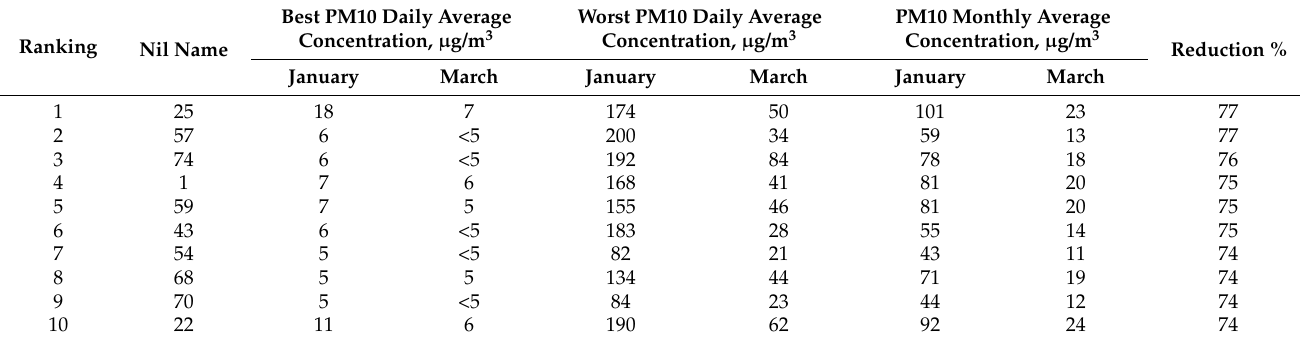
Table 3. Top 10 NILs with the highest PM10 reduction rate between March and January.